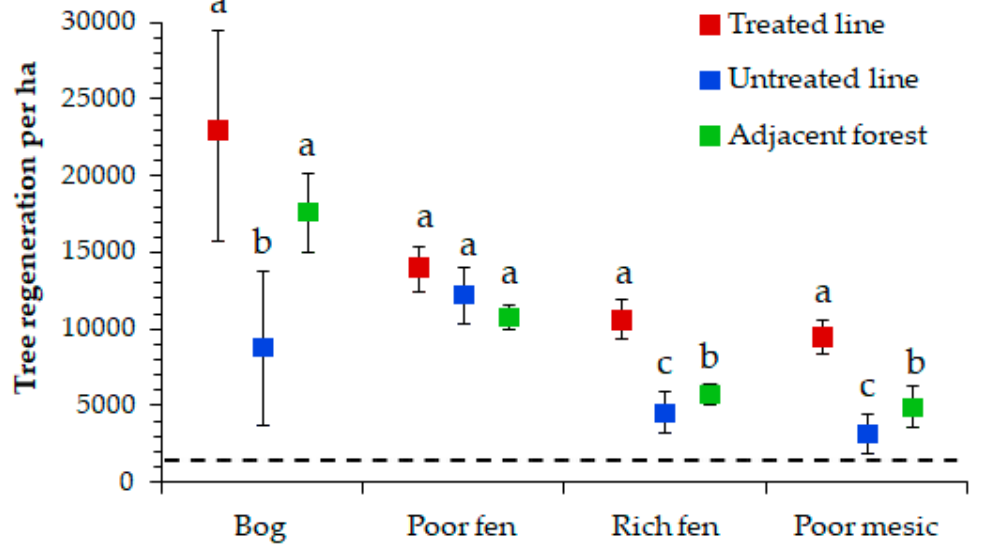
Figure 3. Mean and standard error (error bars) of tree regeneration (diameter at breast height (DBH) < 1 cm), across four ecosites and three treatments. Significance of treatments within each ecosite was tested with a pairwise comparison (Bonferroni adjustment) with different letters indicating significant ( p < 0.017) differences within an ecosite. Note, dashed line represents the amount of planted stems per hectare in treated lines (1300 stems/ha).